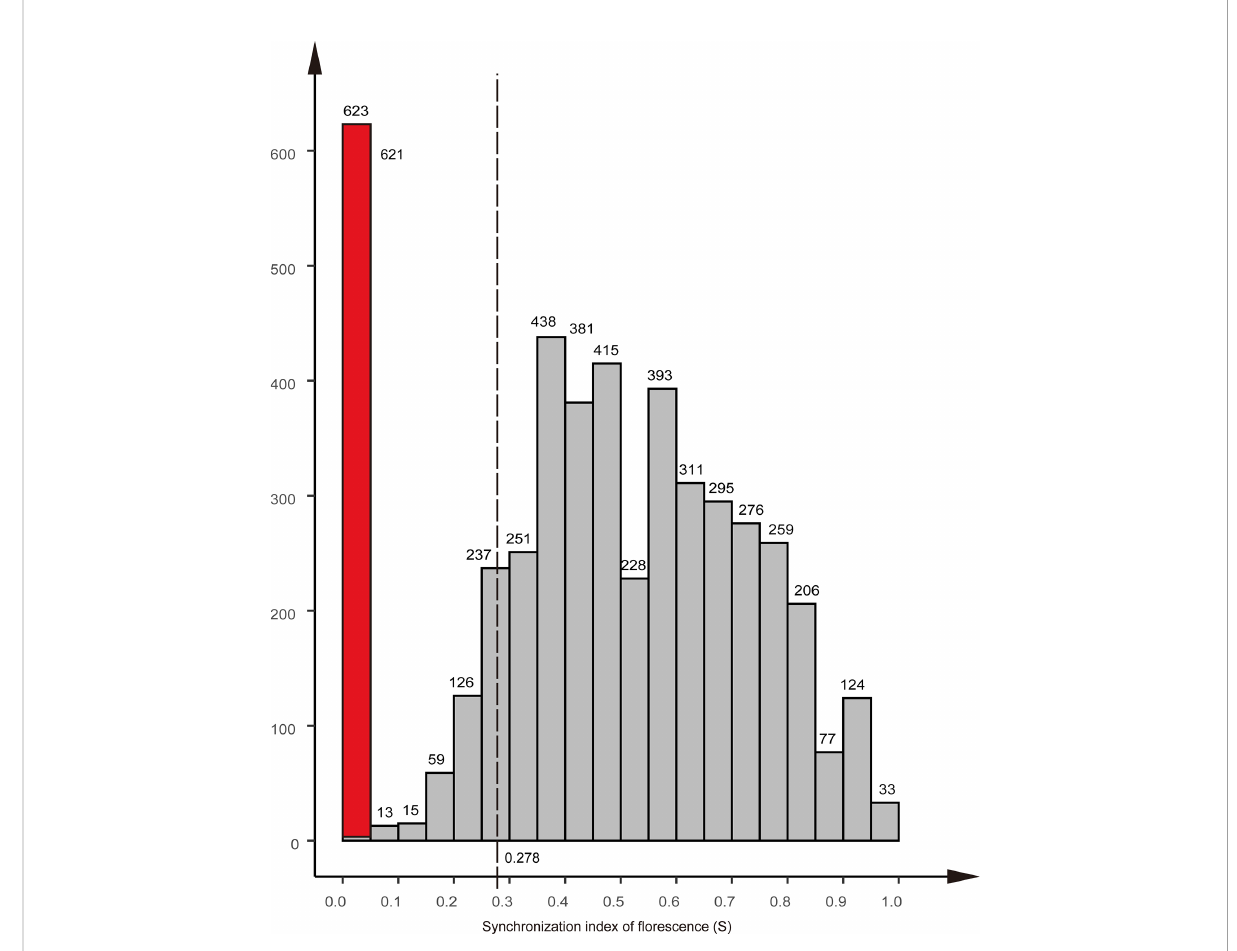
FIGURE 5 Distribution of the synchronization index of fl orescence (S) of the clones in the Chinese r clonal seed orchard. The red column indicates the nine clones that did not produce female fl owers. equal to zero; The dotted line indicates the lowest S-value of mating